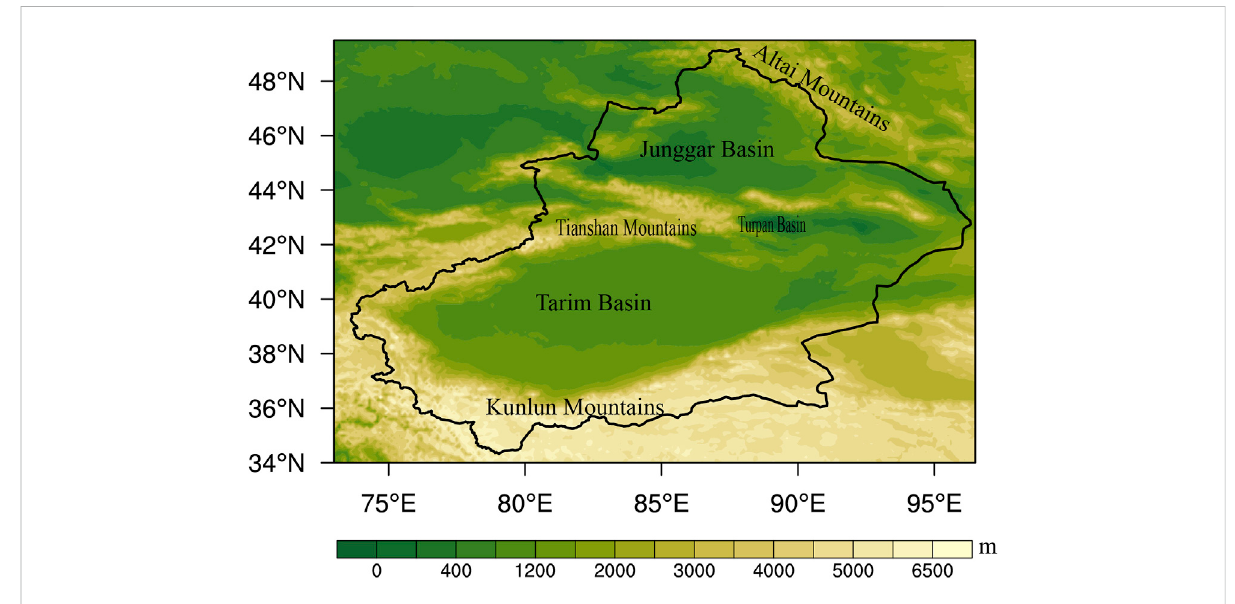
FIGURE 1 Study domain. The color bar represents the altitude of the terrain